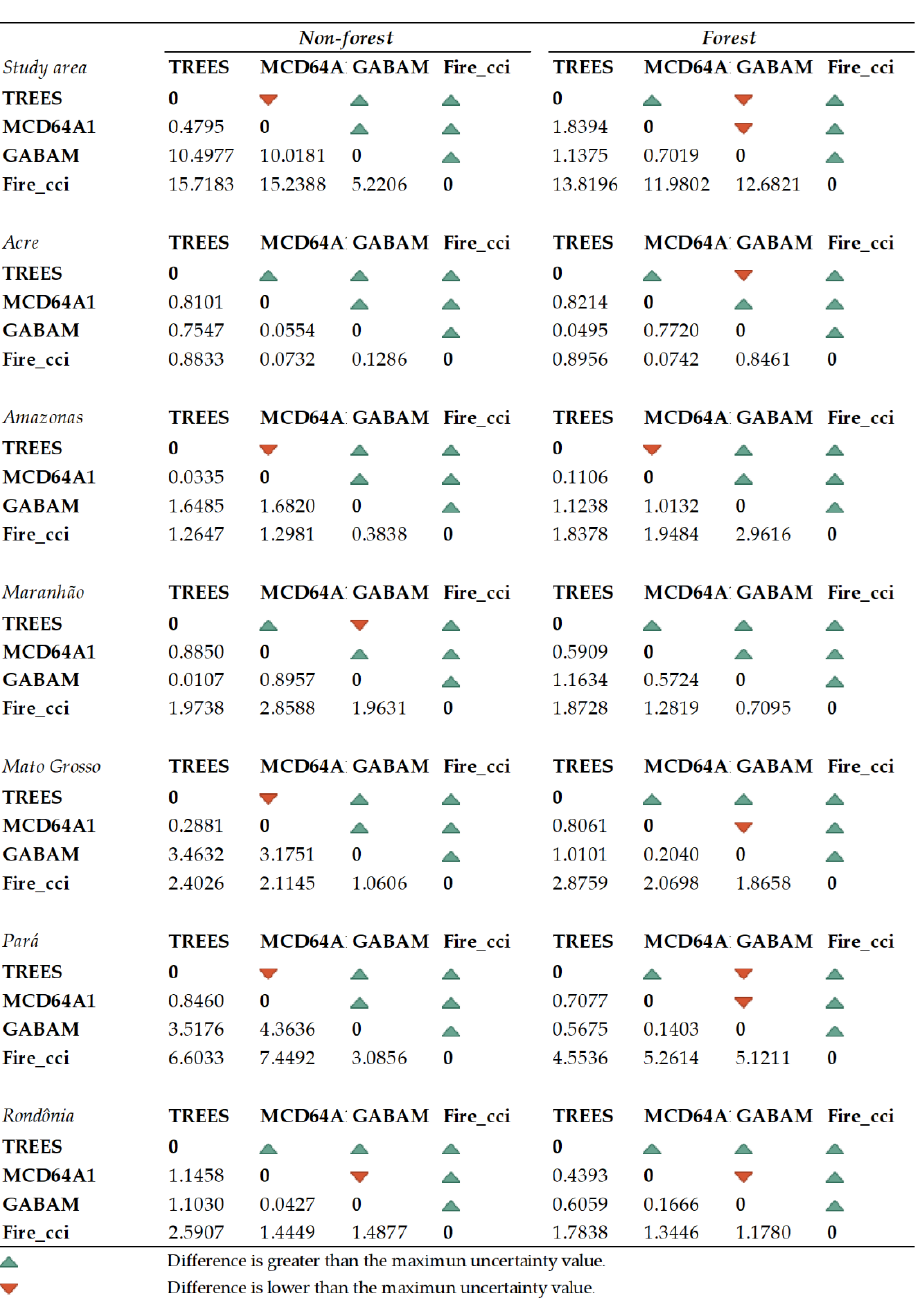
Figure 4. Carbon emissions difference analysis. The lower diagonal contains the absolute value of the difference of carbon emissions (Tg) between the products. The upper diagonal indicates if the difference is greater (green upside triangle) or lower (red downside triangle) than the maximum uncertainty value between them.